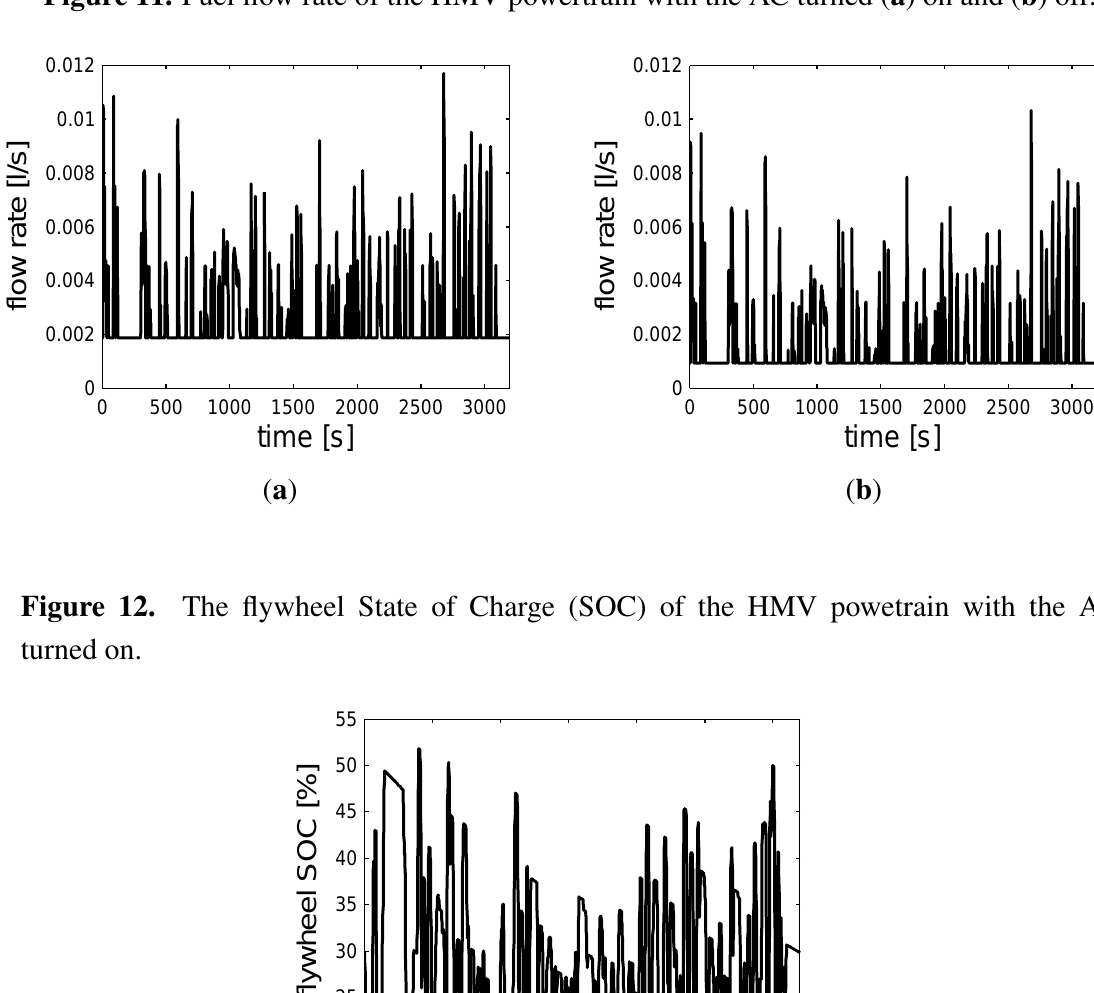
Figure 11. Fuel flow rate of the HMV powertrain with the AC turned ( a ) on and ( b ) off.